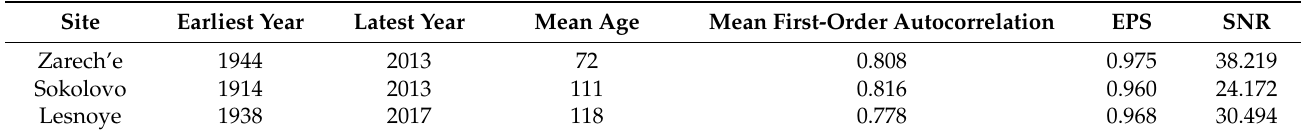
Table 3. Characteristics of the averaged tree-ring chronologies.